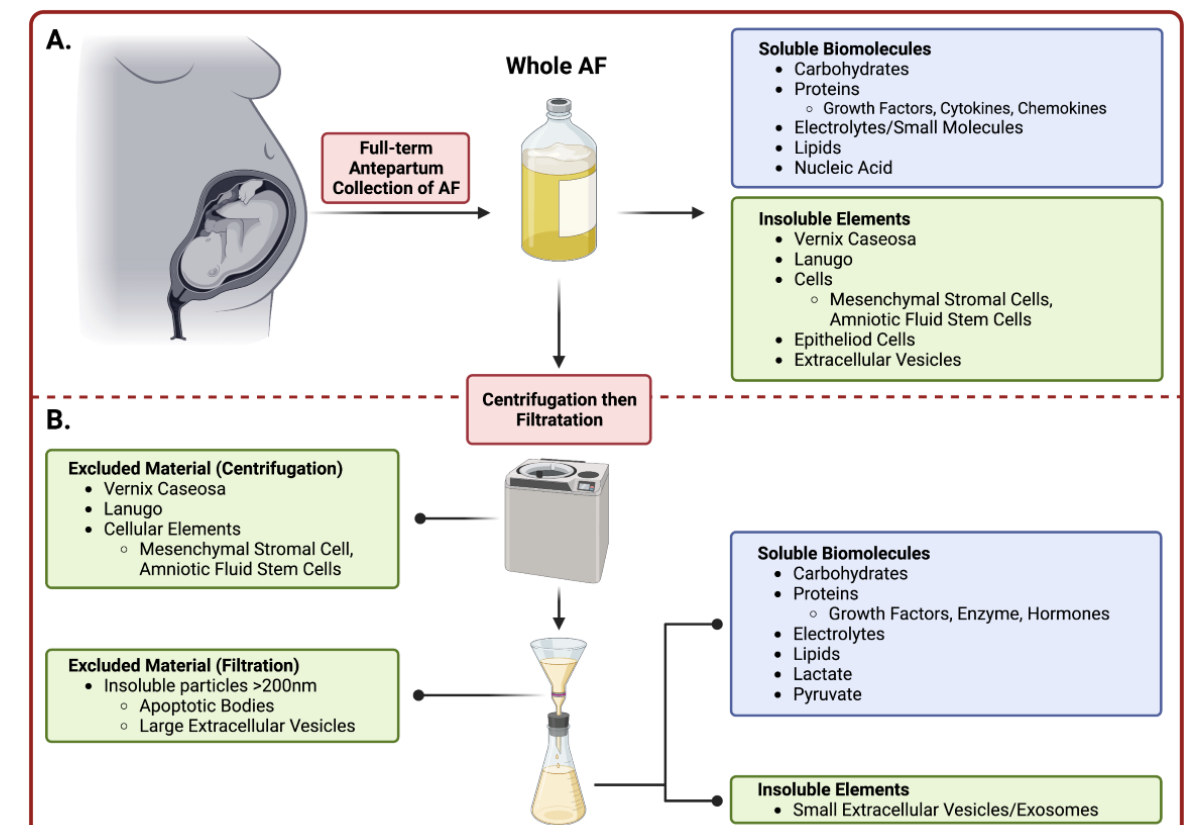
Figure 1. Summary of Amniotic Fluid Collection and Processing. Amniotic fluid is collected during an elective Cesarean delivery prior to removal of the fetus. ( A ) The top panel denotes the constituents in whole amniotic fluid prior to processing. ( B ) The bottom panel (below dashed line) describes the preparatory stages of purifying whole amniotic fluid into cell-free amniotic fluid. Upon manual processing including centrifugation and subsequent filtration, the collected eluent is considered cell-free and comprised of vital soluble biomolecules and small insoluble EVs. (Image created with Bio Render).